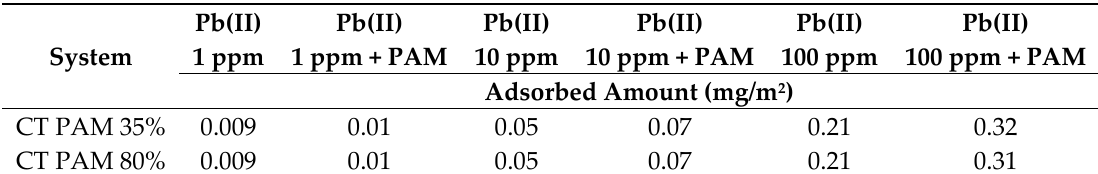
Table 2. Influence of CT PAM presence on the amount of lead(II) adsorbed on the montmorillonite surface; both adsorbates were added together.